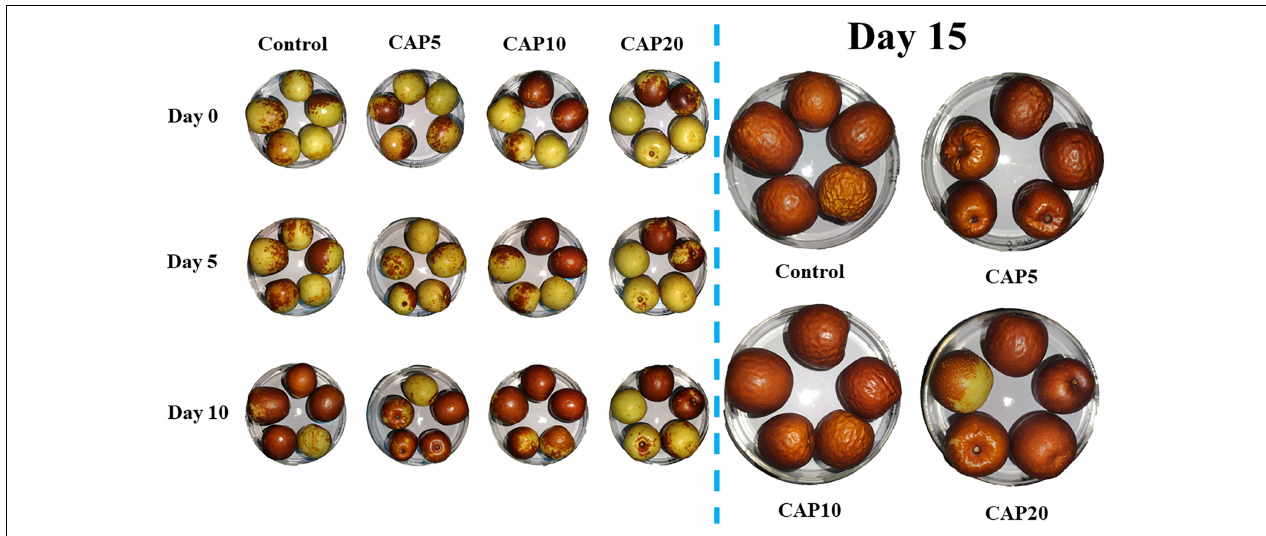
FIGURE 1 | Visual appearance of jujubes in CAP5, CAP10, CAP20, and control during 15-day storage at 4 ◦ C and 90% relative humidity (RH).